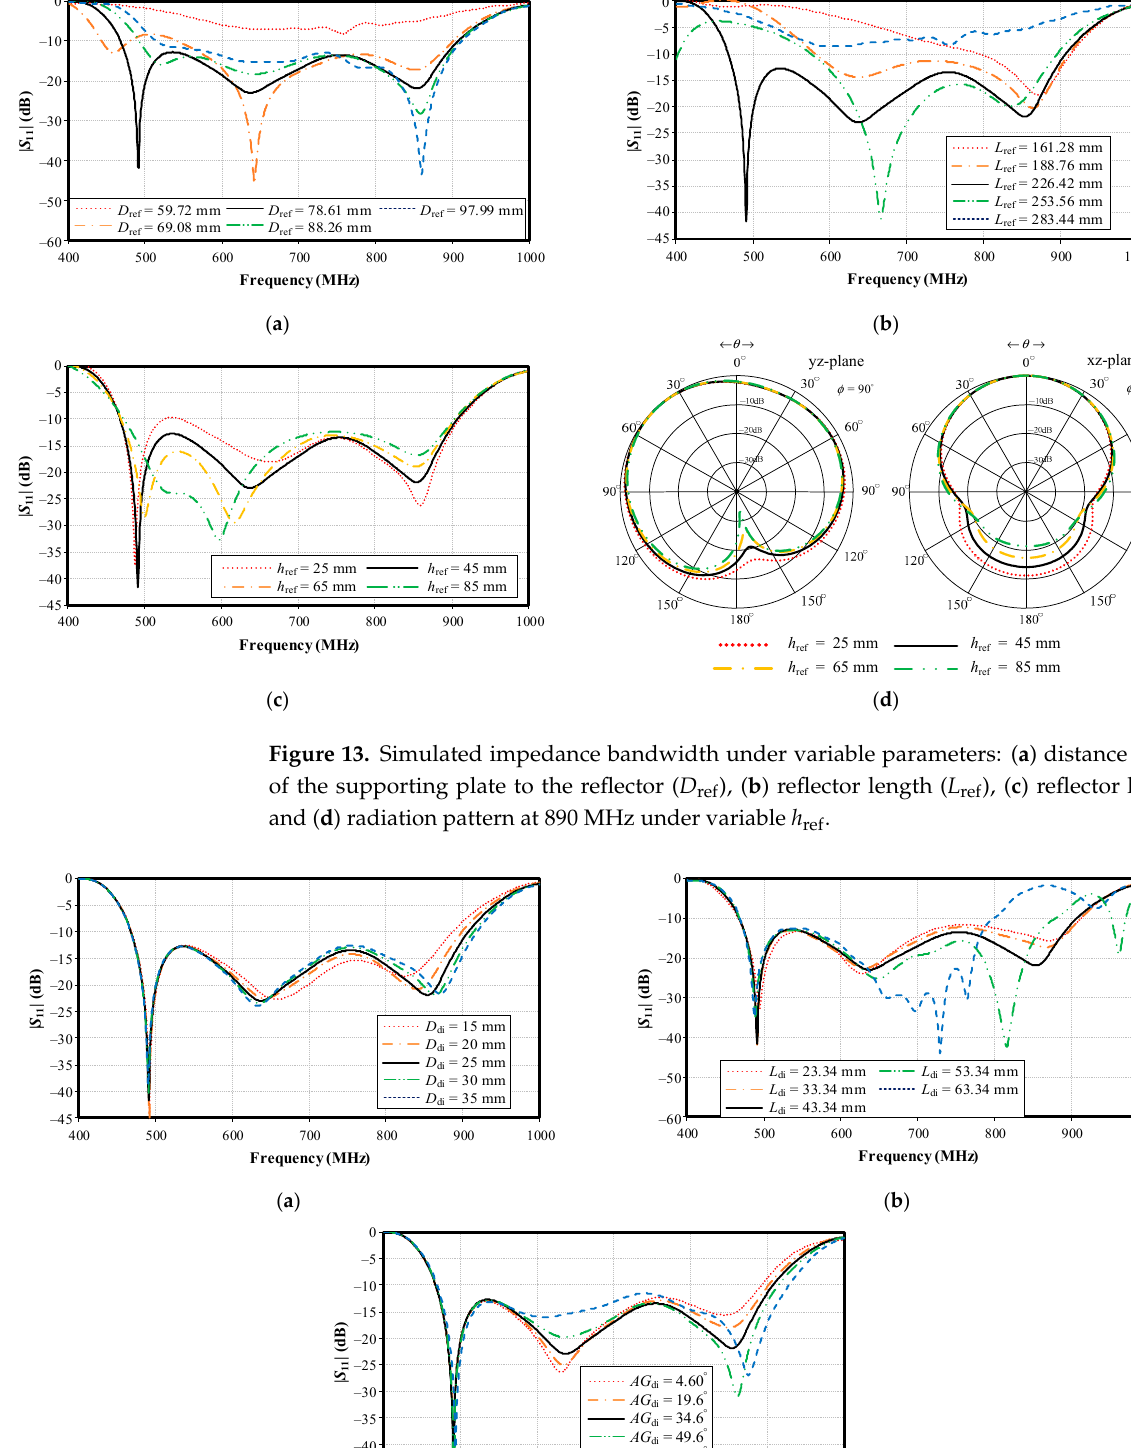
of folded bowtie radiator ( W di ), ( b ) angle of the folded bowtie radiator ( AG dp ).